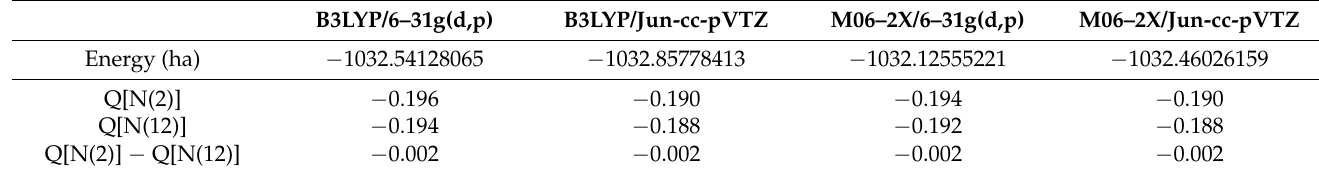
Table 1. DFT-computed energies (hartree units) and Hirshfeld charges (atomic units) of the two nitrogen atoms of 4